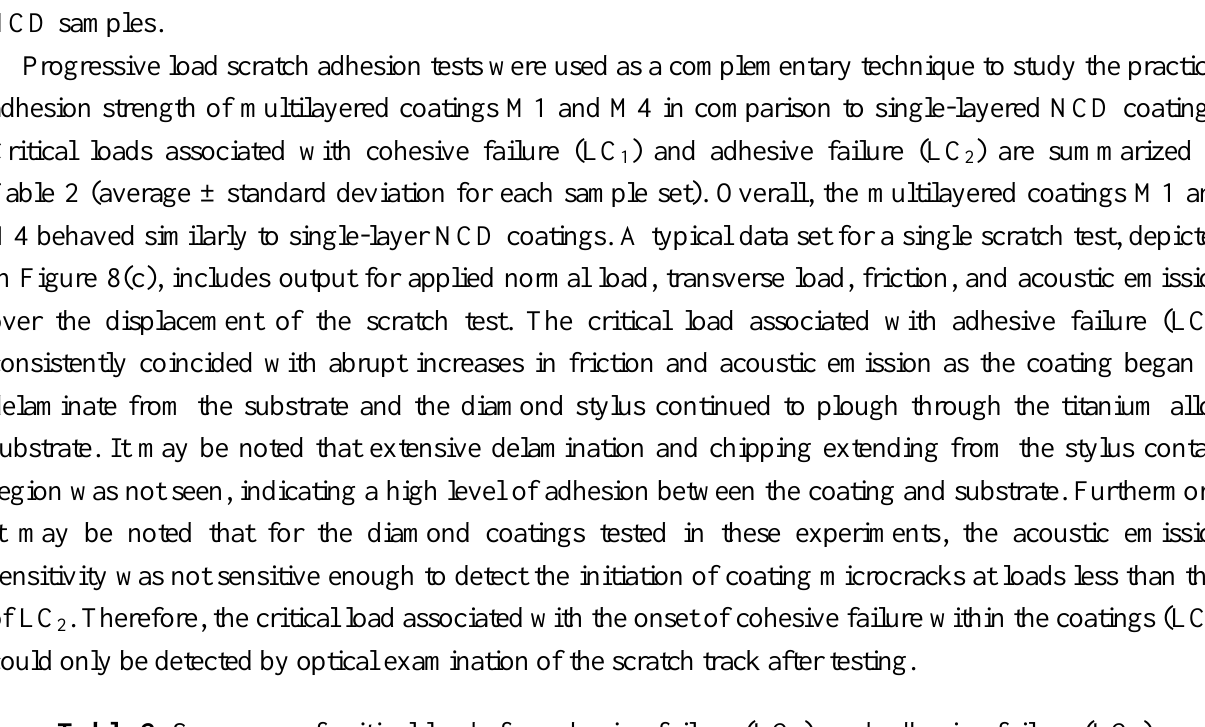
), and adhesive failure (LC 1